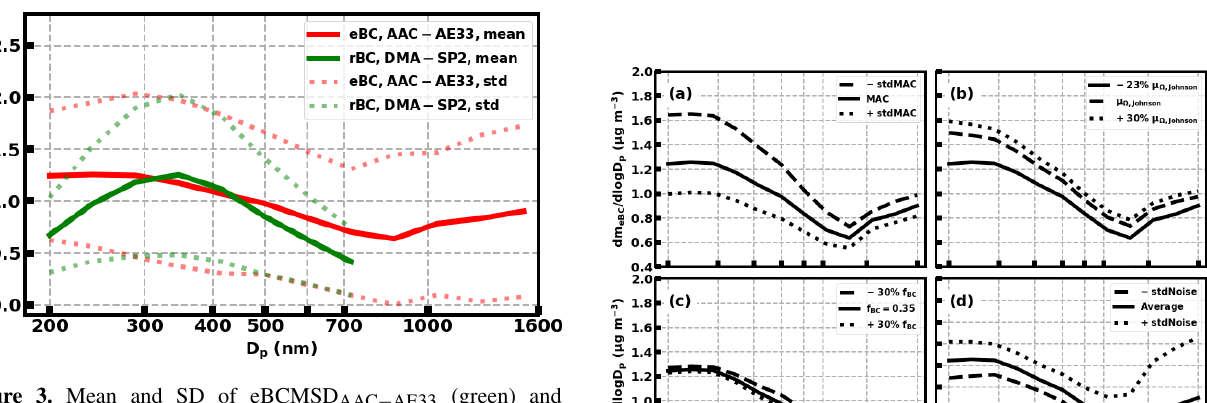
Figure 3. Mean and SD of eBCMSD AAC − AE33 (green) and rBCMSD DMA − SP2 (red) during the measurement period. Mean BCMSD was denoted by the solid line. SD of BCMSD was denoted by the dotted line.